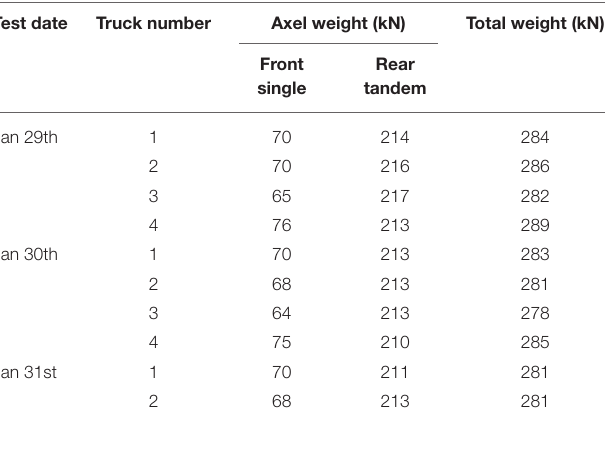
TABLE 7 | Stage 2 load test: truck load weights.